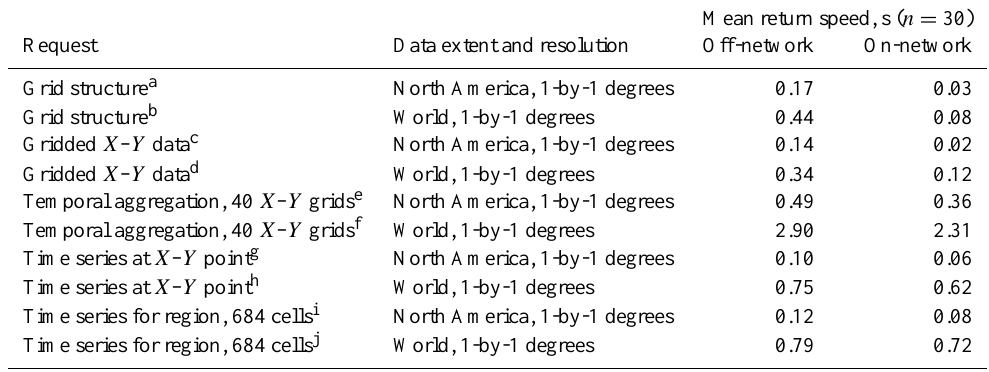
Table 1. Results of load testing in Apache JMeter; network speeds are in seconds to request completion. The off-network tests were performed over a wireless internet connection; on-network tests were performed with a wired, direct network connection to the